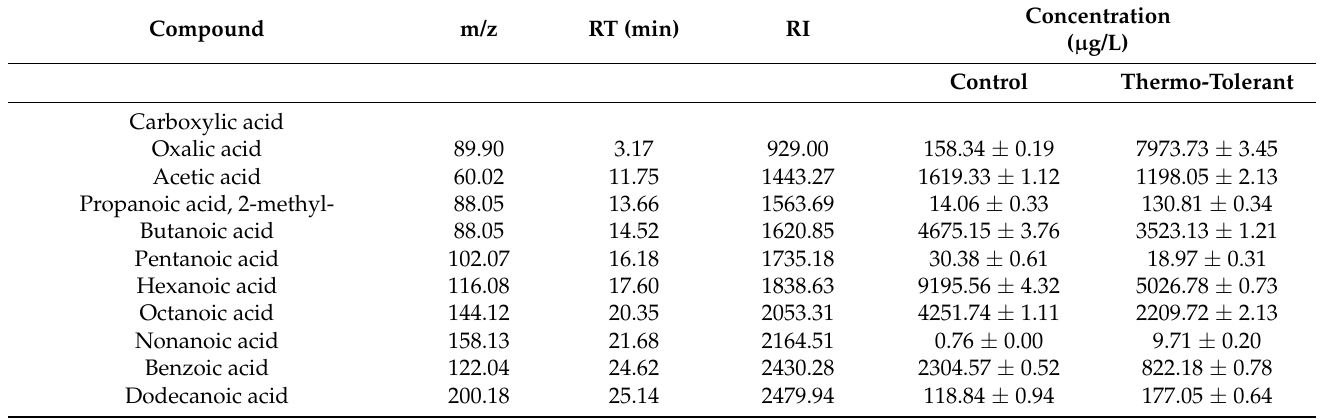
Table 2. Volatile compounds in inoculated milk samples analysed by SPME-GC-MS are shown. Data are presented as mean ± standard deviation ( n = 3). M/z refers to mass-to-charge ratio, RT refers to retention time, RI refers to retention index and ND refers to not